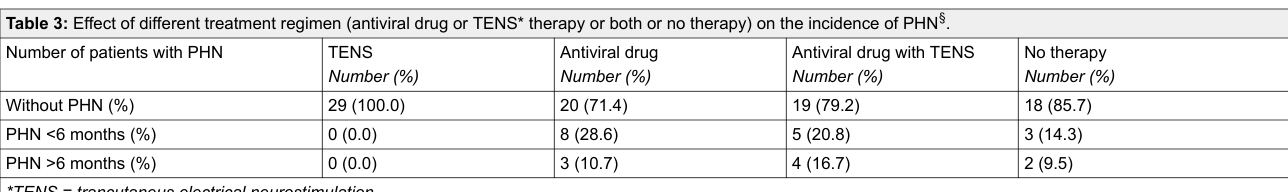
Table 3: Effect of different treatment regimen (antiviral drug or TENS* therapy or both or no therapy) on the incidence of PHN § . Number of patients with